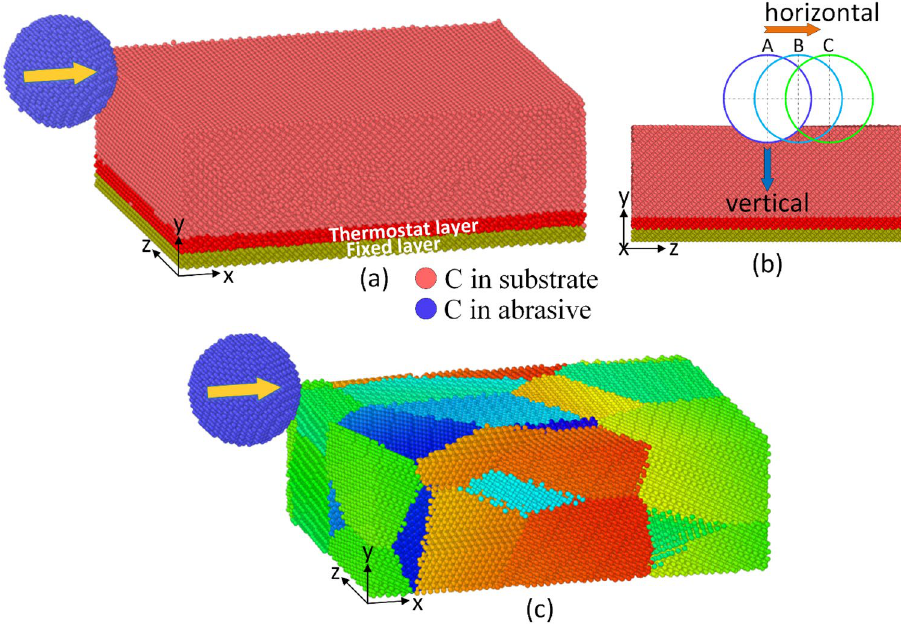
Figure 1. The simulation models: ( a ) single crystal diamond, ( b ) multi-machining, and ( c ) polycrystalline